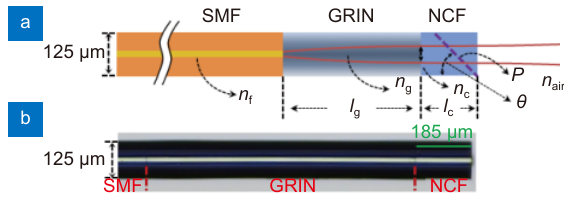
Fig. 1 | Schematic diagram of the spacer-removed probe. n f , n g , n c , and n air are the refractive index of SMF core, GRIN fiber at the center, NCF, and air, respectively; l g and l c are the length of GRIN fiber and NCF; P and θ are the polishing surface and tilt